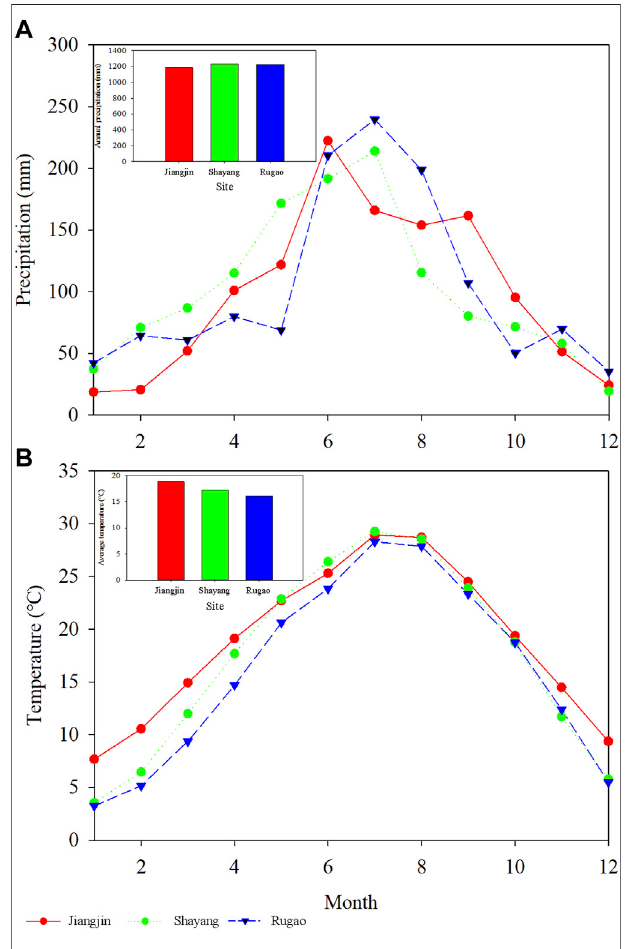
FIGURE 1 | Average precipitation (A) and temperature (B) at the experimental sites from 2006 to